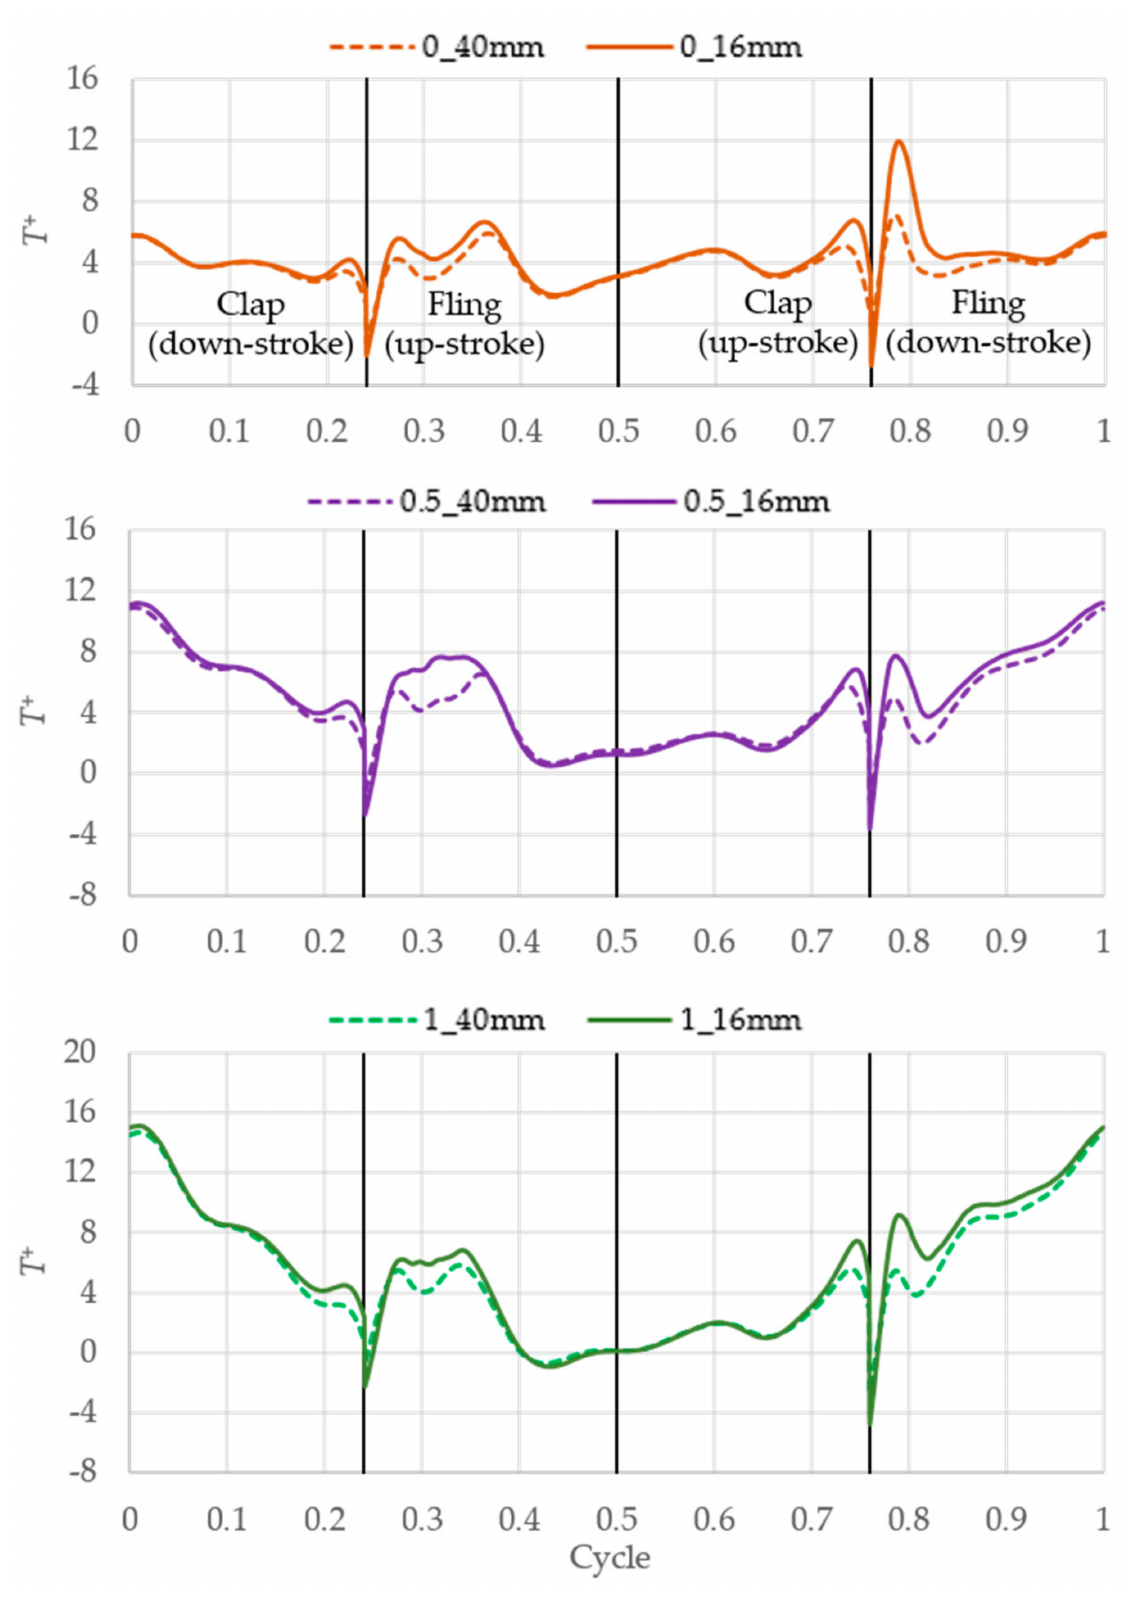
Figure 15. Time courses of torque generated by the wing pair for various inflow